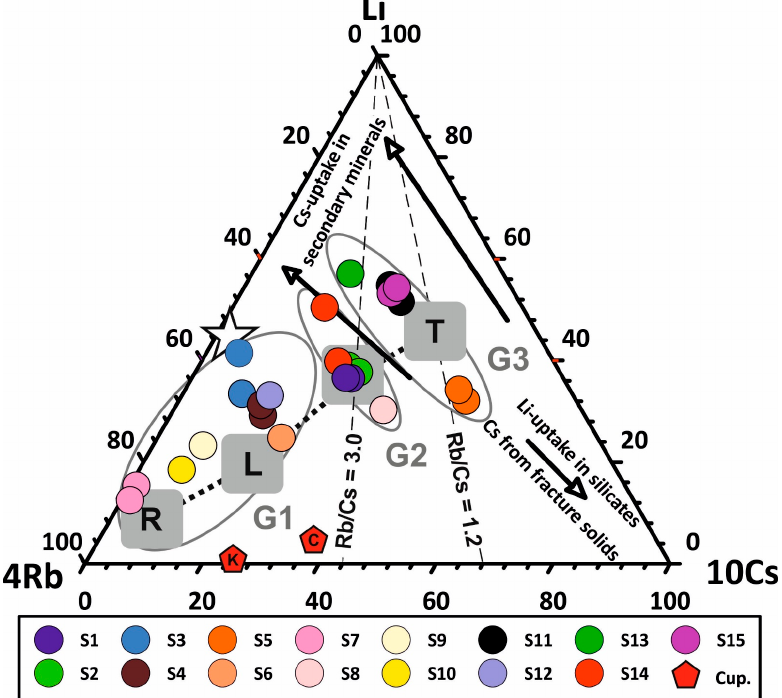
Figure 6. Li-Rb-Cs ternary diagram of the water samples (weight basis), modified after [103]. Three different groups of springs that correspond to the different steps of the water–rock interaction path (dotted line), are evidenced: (G1) groundwater of the calcium-bicarbonate water domain in the “limestone area” including S3, S4, S6, S7, S9, S10, and S12 whose water chemistry is dominated by simple interactions with calcites and dolomites of the Mesozoic limestones; that cluster contains: the “R” gray field (isochemical dissolution of mean crustal rocks) [103], the white star that depicts the median composition of carbonate aquifers with shallow circulation from central Italy [109], and the mean limestones composition “L” [108]; (G2) groundwater of the calcium-sulphate domain in the “evaporites area” including S1, S2, and S14 whose chemical compositions are attributable to a more extensive dissolution of the first groups of the sulphate minerals; and (G3) groundwater with the highest concentrations of Li and Cs including S5, S11, S13, and S15, whose geochemistry suggests a deep-seated circulation with respect to the first two groups. However, groups 2 and 3 are enclosed between 1.2 < Rb/Cs < 3.0, typical of thermal waters interacting with the Upper Triassic Burano Formations (“T” = Tuscany thermal waters [110]). The Li-Rb-Cs contents of the carbonatitic (C) and silicate (K) fractions of Cupaello rocks are shown with red pentagons (Cup.) [41,42]. See Figure 1 for spring